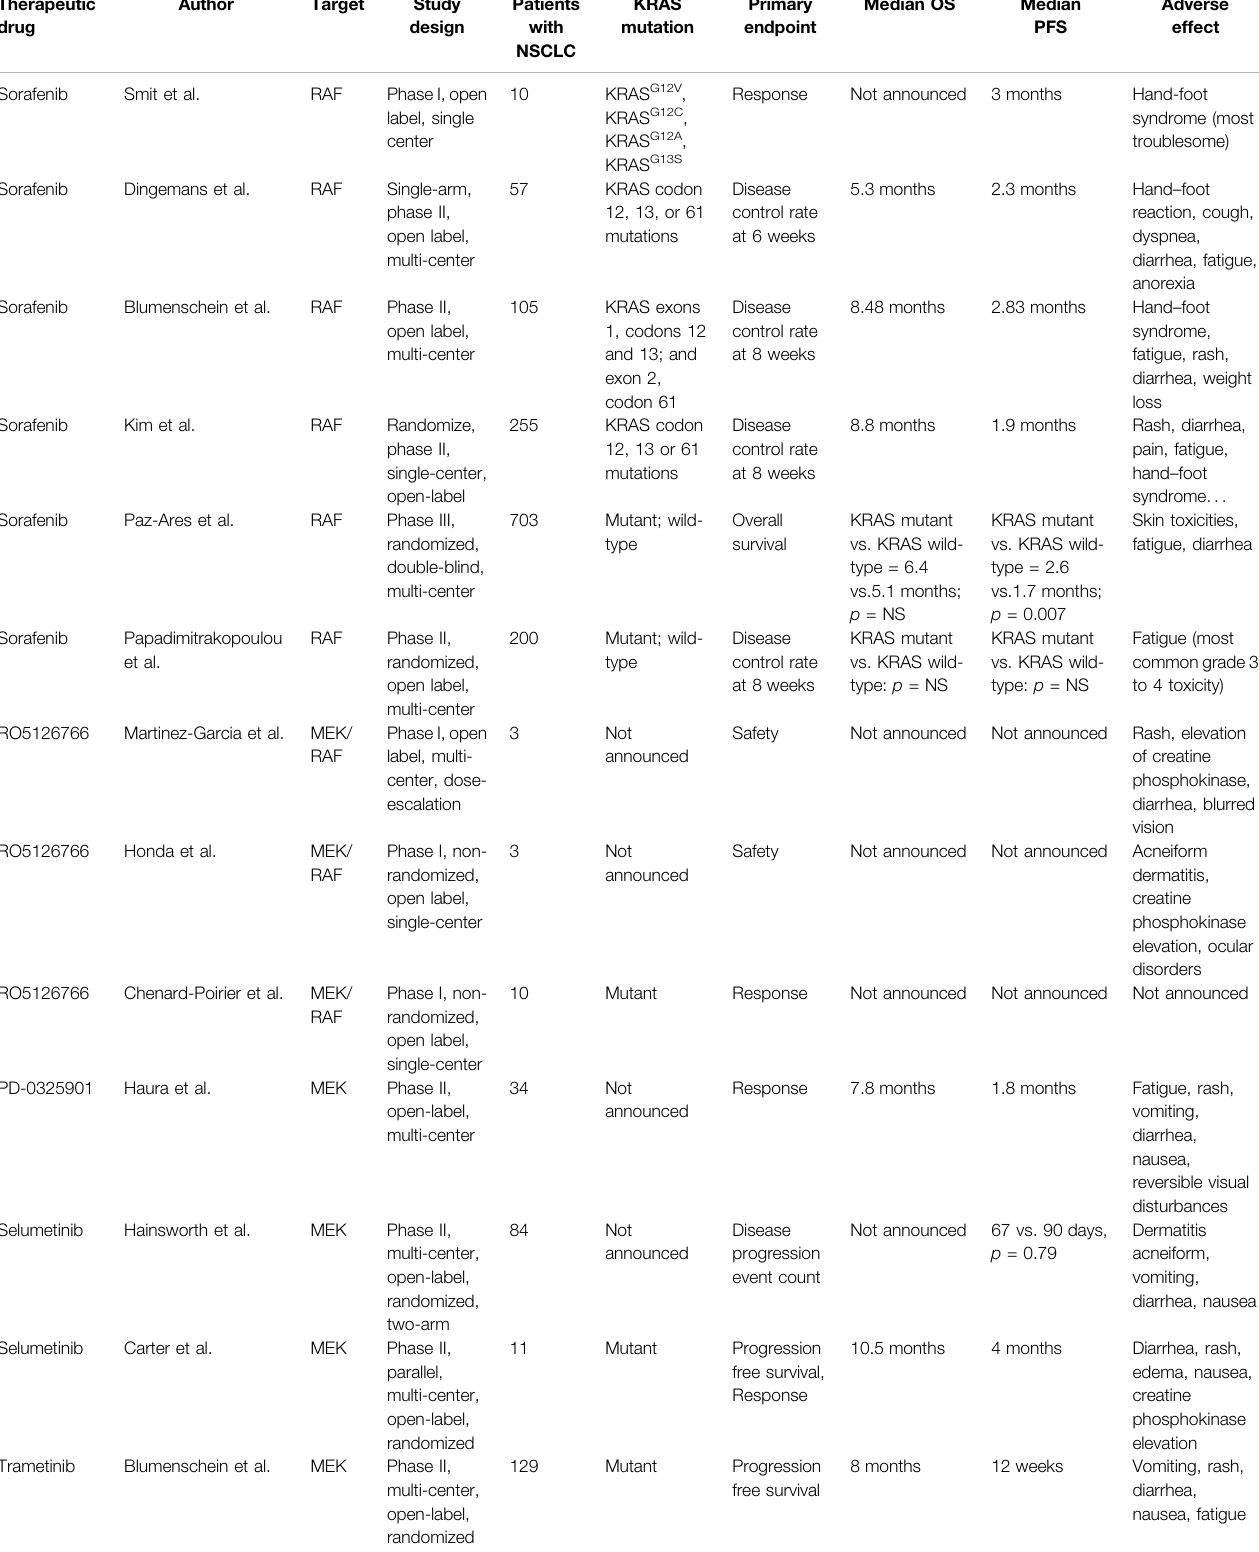
TABLE 2 | Completed clinical trials about therapeutic drugs targeting KRAS-related pathways in